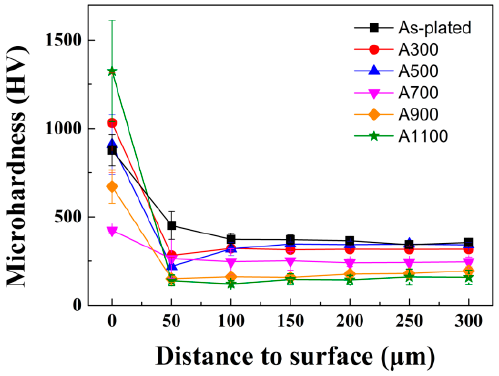
Figure 6. Microhardness evolution with increasing annealing temperature.